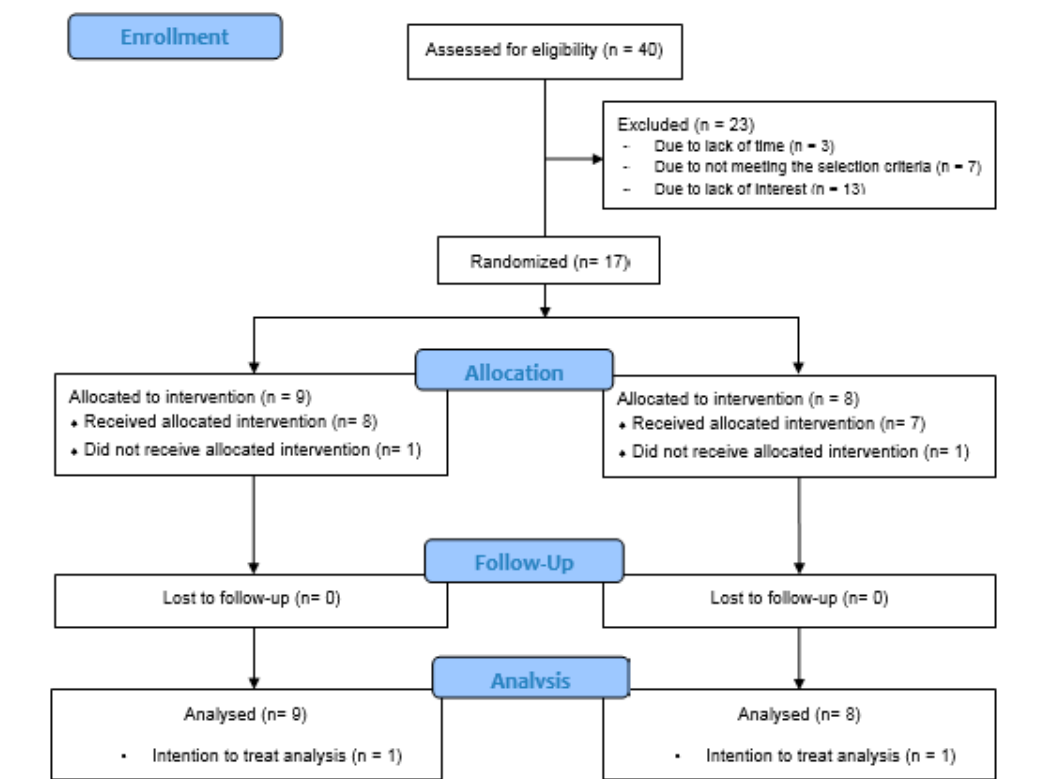
Figure 1. Study flow diagram.